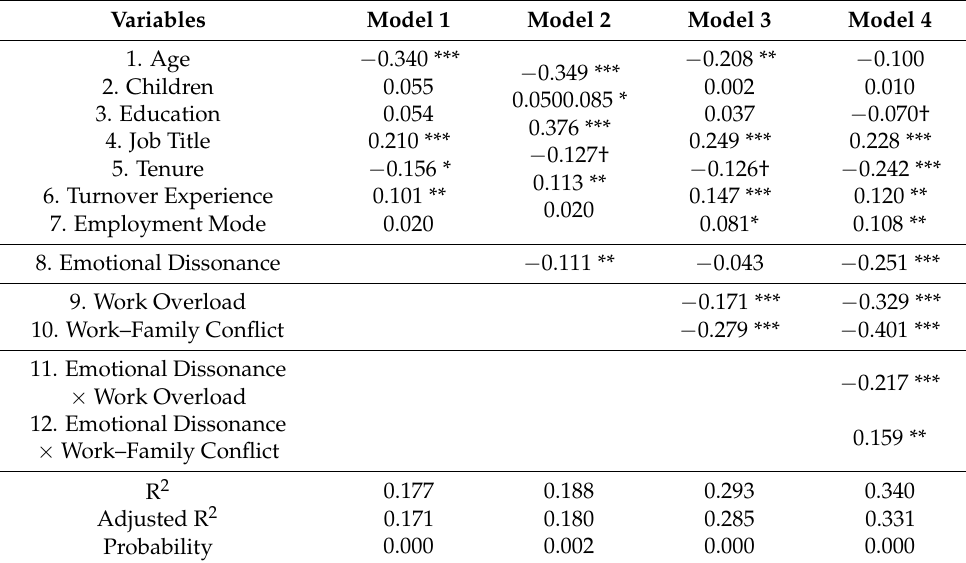
Table 4. The regression results of emotional dissonance on intrinsic